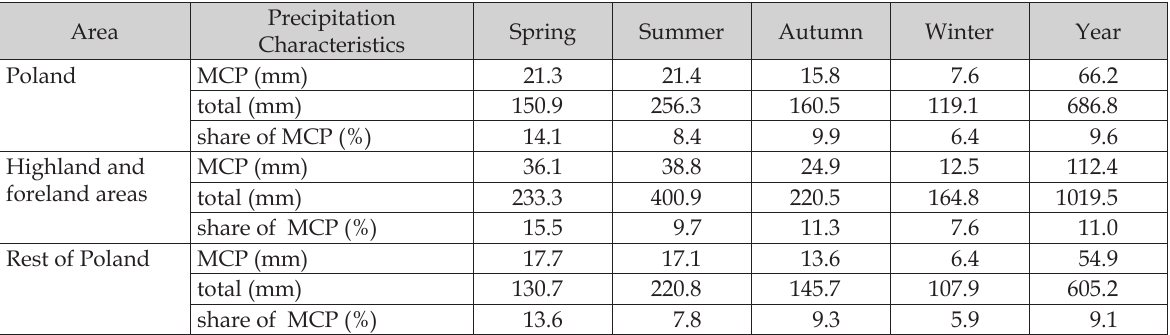
Table 1. Mean seasonal and annual Mediterranean precipitation (MCP) sums, total precipitation amounts and the share of MCP in precipitation totals in the area of Poland, in the highlands and their forelands, and in the remaining part of Poland